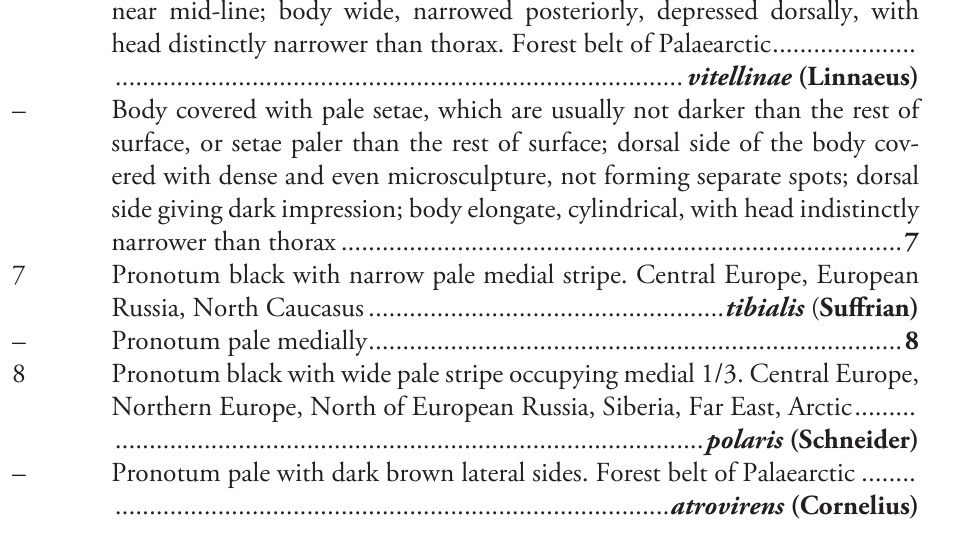
Dorsal coloration “dark”; tubercle EP pigmented. Taiwan ... similis (Chûjô) Body covered with black setae, which are usually darker than the rest of sur- face; dorsal side of the body covered unevenly with microsculpture, forming separate dark spots between tubercles; pronotum dark with 2 yellow spots near mid-line; body wide, narrowed posteriorly, depressed dorsally, with